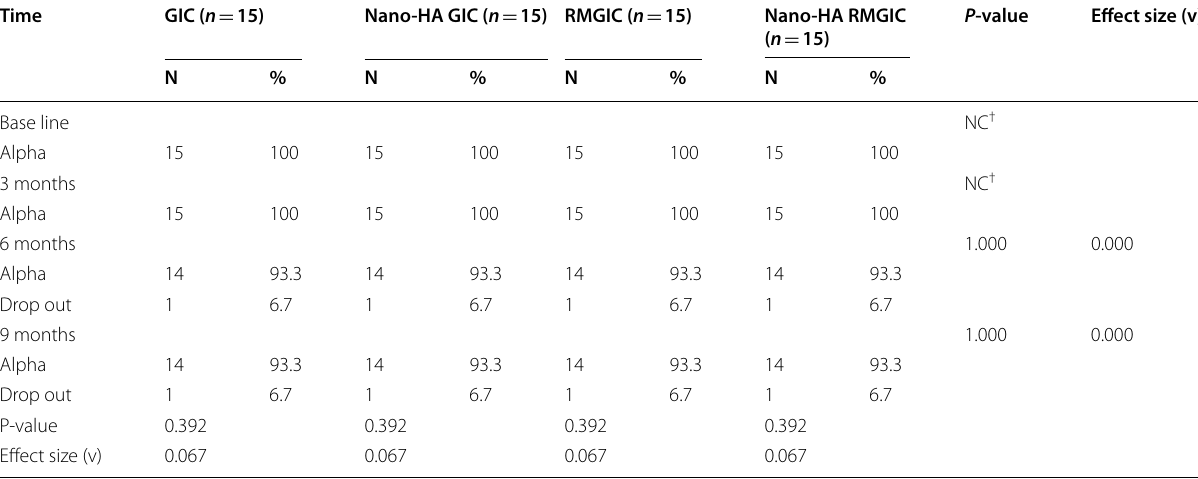
*Significant at P